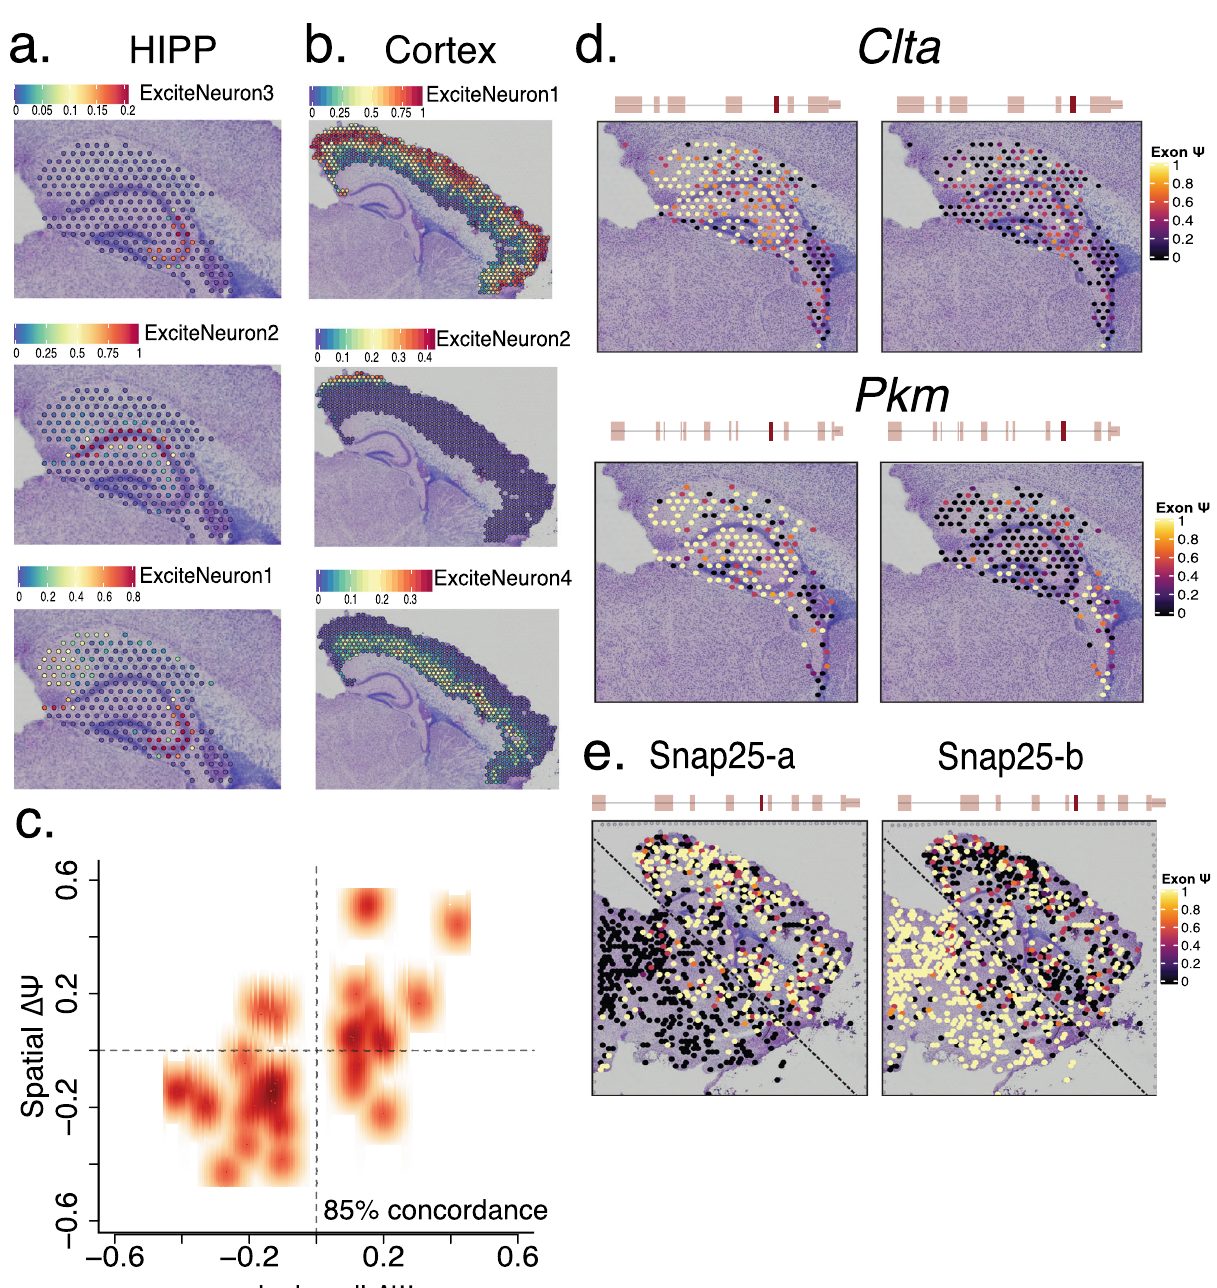
Fig. 6 Slide isoform sequencing (sl-ISO-Seq) con fi rms spatial localization of splicing changes. a Spatial localization of hippocampal single-cell excitatory neuron subtypes using gene-expression similarities to HIPP short reads. Color of spot indicates percentage of transcripts corresponding to indicated cell type. b Spatial localization of cortical excitatory neuron subtypes using gene-expression similarities to PFC short reads. Color of spot indicates percentage of transcripts corresponding to indicated cell type. c Scatter plot of the Δ Ψ between HIPP and PFC from the single-cell data, and the Δ Ψ between HIPP and cortex from 10X Visium spatial data ( r 2 = 0.6). d Spatial distribution of alternatively spliced exons in Clta and Pkm genes in the hippocampal and choroid plexus regions. Color of spot indicates Ψ values for each exon. e Spatial distribution of two mutually exclusive, alternatively spliced exons in Snap25 gene across the whole slide. Color of spot indicates Ψ values for each